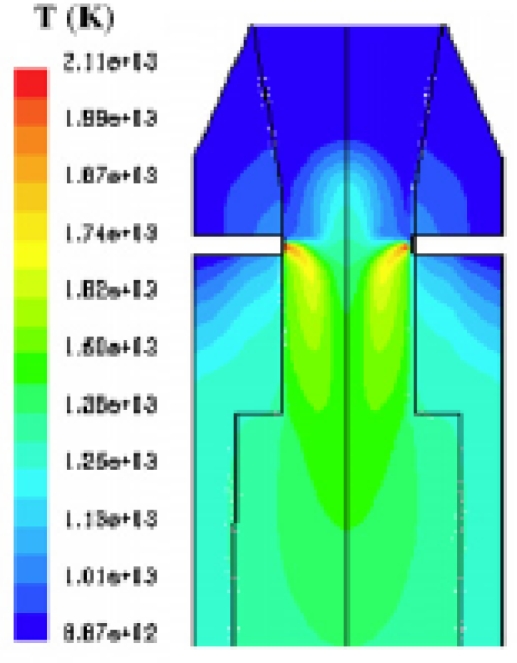
Temperature profile in the reactor [16].